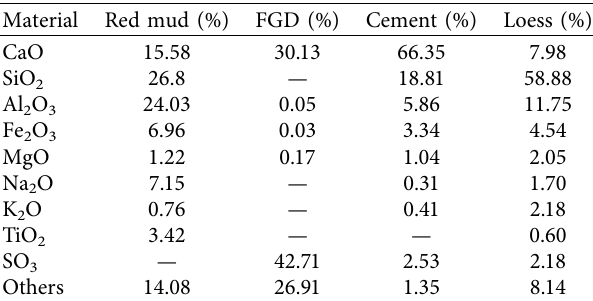
Table 2: Chemical compositions of major materials (%).